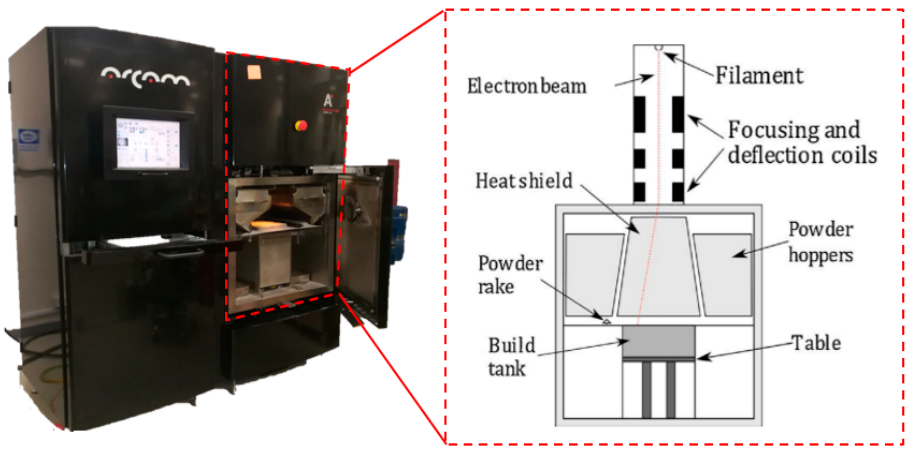
Figure 3. ARCAM A2 machine diagram. Table 1. Default EBM process